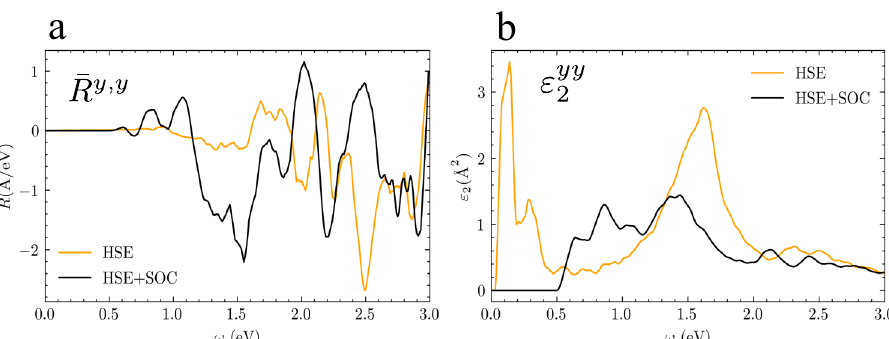
Fig. 9 Shift vector and transition intensity in monolayer Bi. BZ-integrated a shift vector and b transition intensity for σ yyy in monolayer Bi computed with HSE and HSE + SOC.